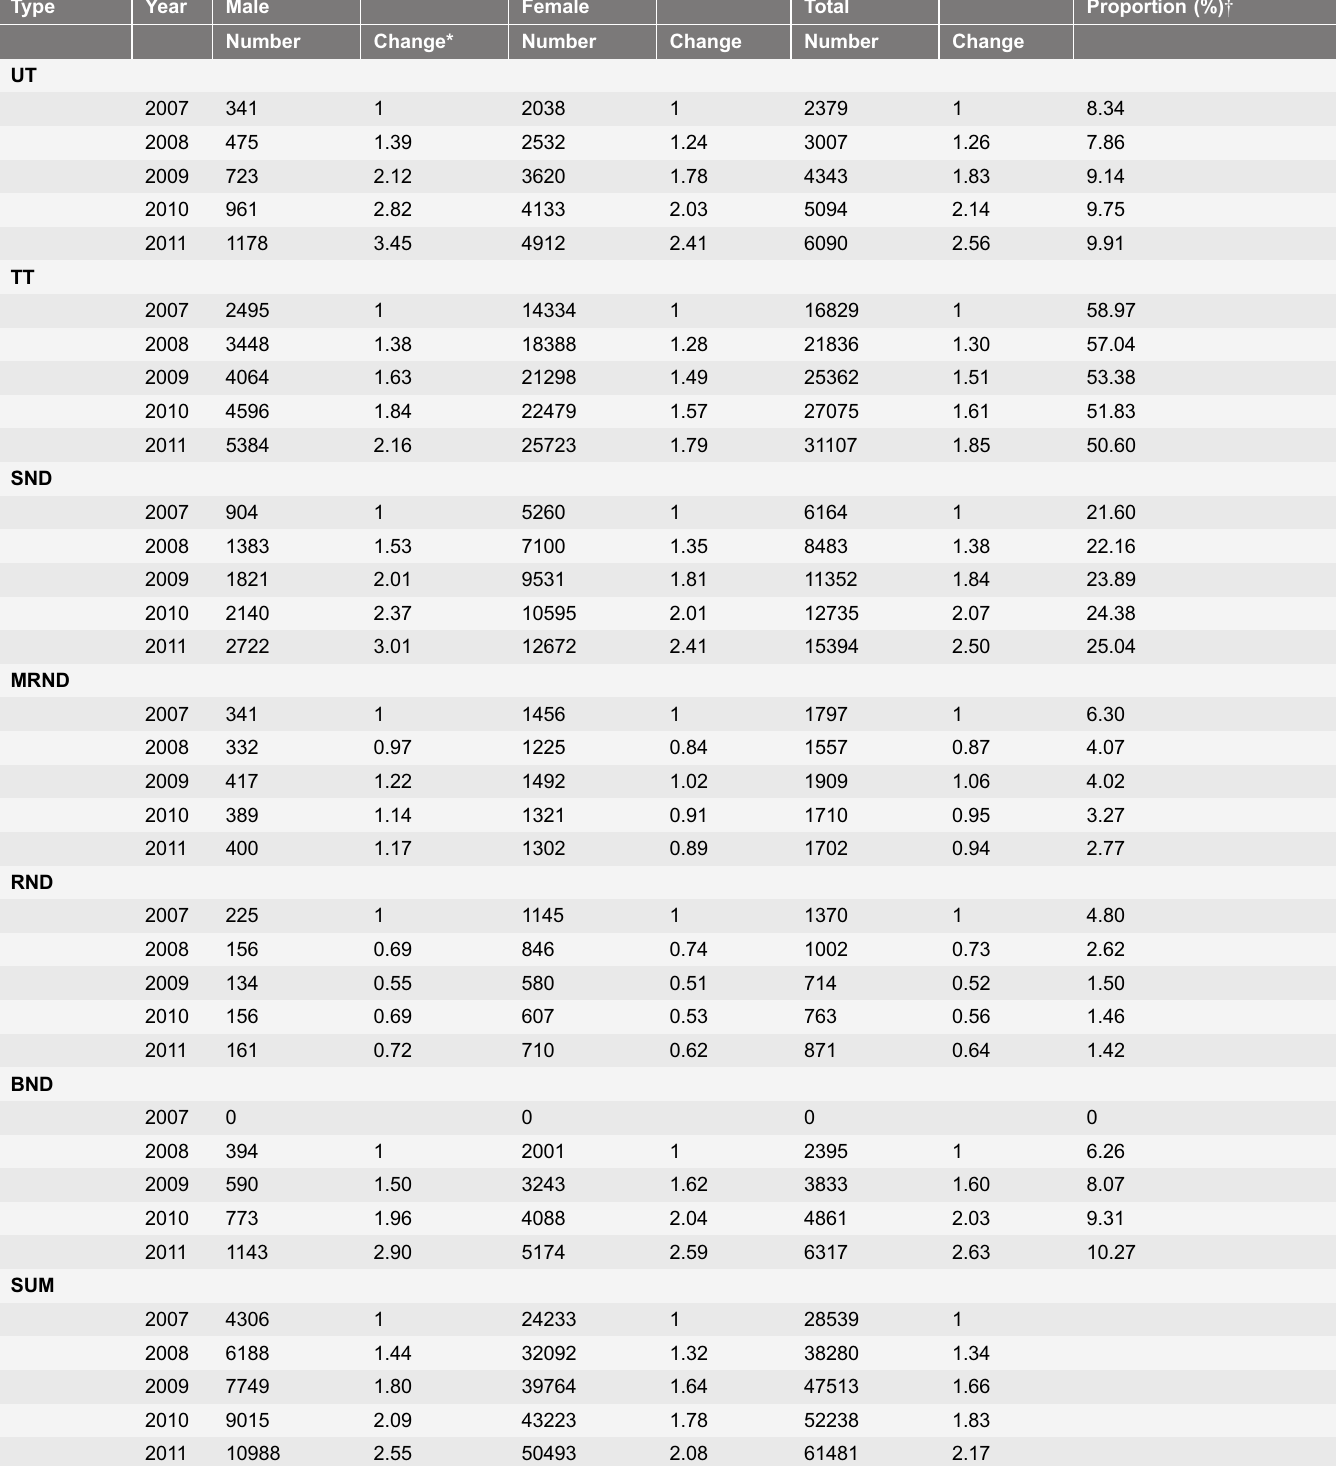
Table 2. The number and proportion of thyroid surgeries.